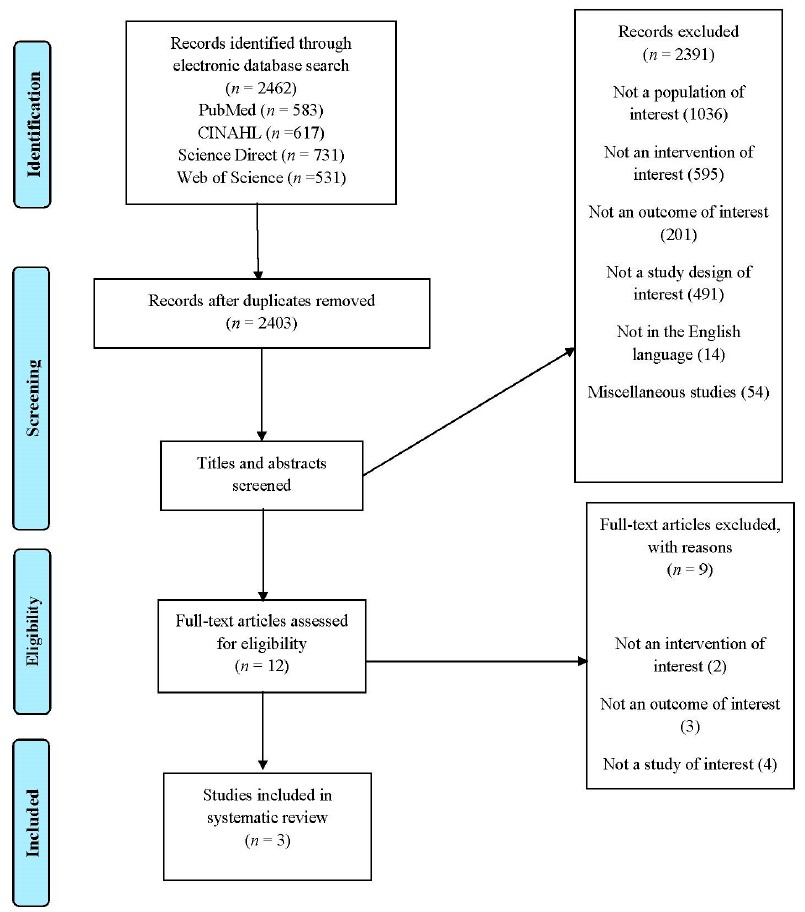
Figure 1. PRISMA flow diagram of included studies.